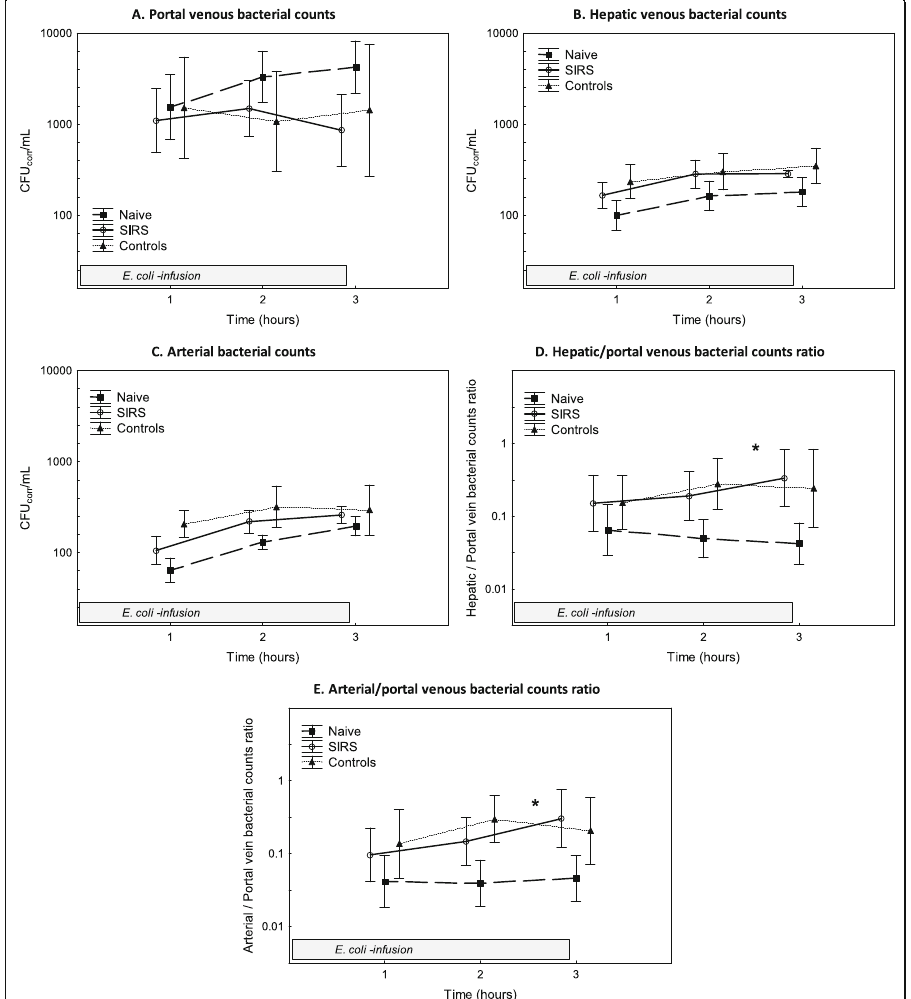
( a – c ). The ratio of hepatic to portal venous bacterial counts and the ratio of arterial to portal venous bacterial counts during the E. coli infusion ( d , e ). Values are expressed as mean ± SEM (standard error of the mean). * p < 0.05. Difference between the SIRS and naive group as assessed with ANOVA III